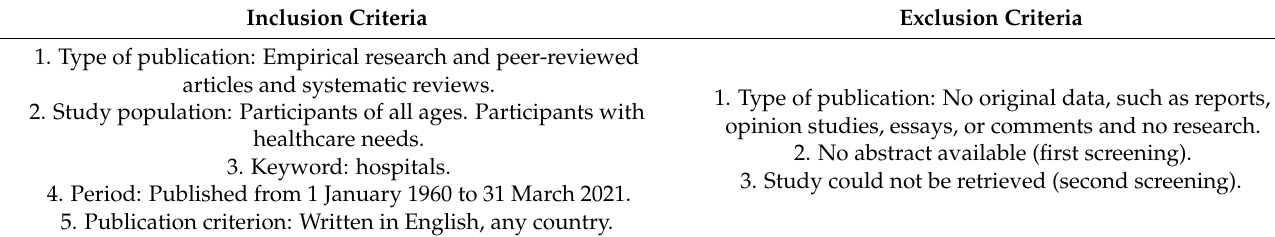
Figure 1. Flow diagram of the study selection process. Table 1. Inclusion and Exclusion